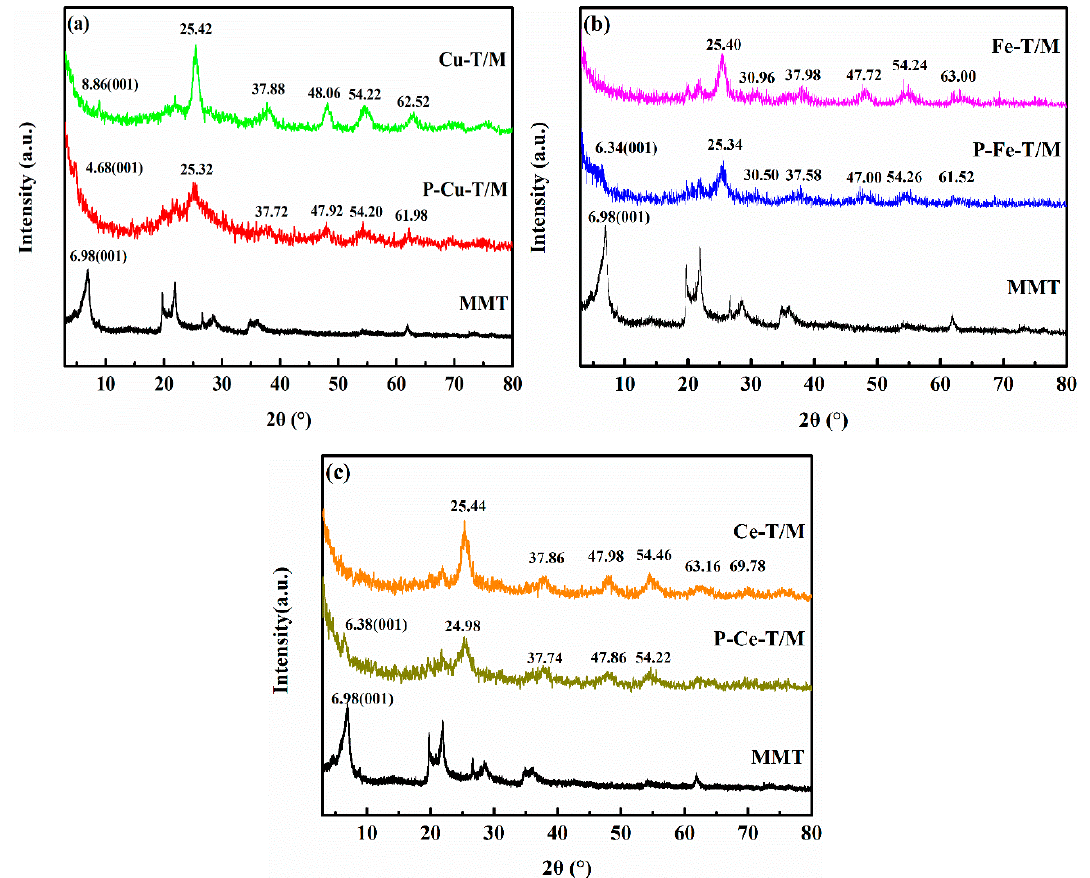
Figure 1. X-ray di ff raction (XRD) patterns of MMT and ( a ) Cu-T / M, ( b ) Fe-T / M, ( c ) Ce-T / M with Figure 1. X-ray diffraction ( XRD) patterns of MMT and ( a ) Cu-T/M, ( b ) Fe-T/M, ( c ) Ce-T/M with their their precursor.